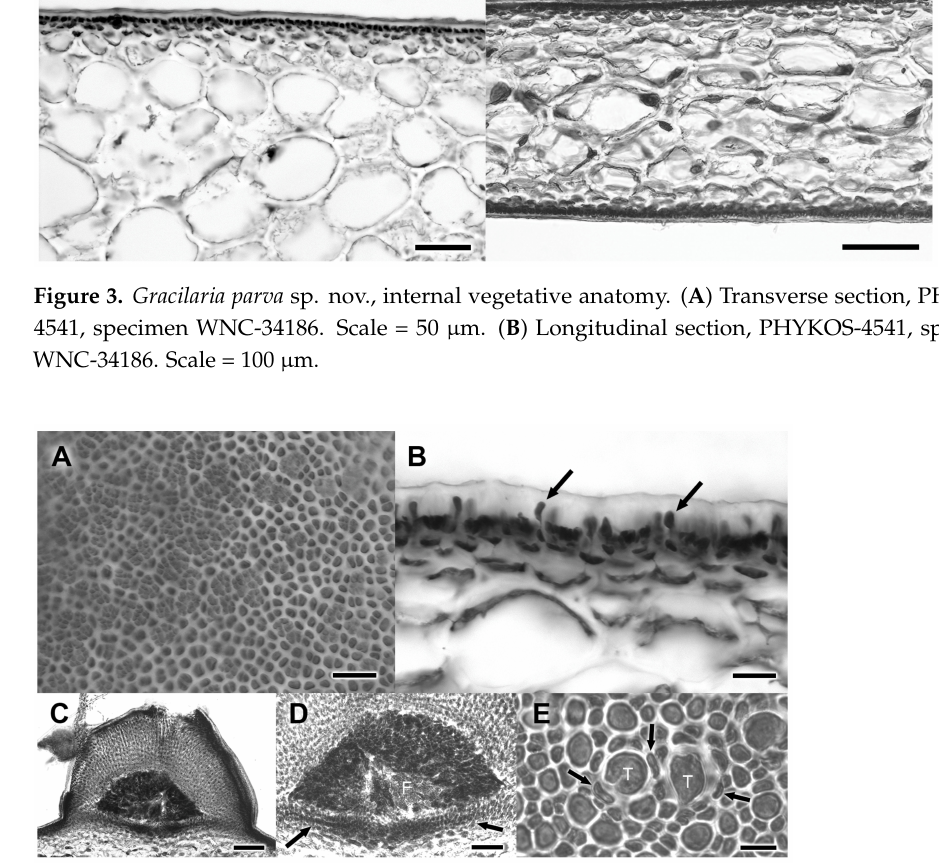
Figure 4. Gracilaria parva sp. nov., reproductive structures. ( A ) Surface view of spermatangial sorus, WNC-34055 slide A. Scale = 20 µ m. ( B ) Transverse section of spermatangial sorus showing shallow, textori-type conceptacles and surrounding anticlinally elongated cells (arrows), WNC-34055 slide B. Scale = 20 µ m. ( C ) Transverse section through mature cystocarp, WNC-34186 slide A. Scale = 100 µ